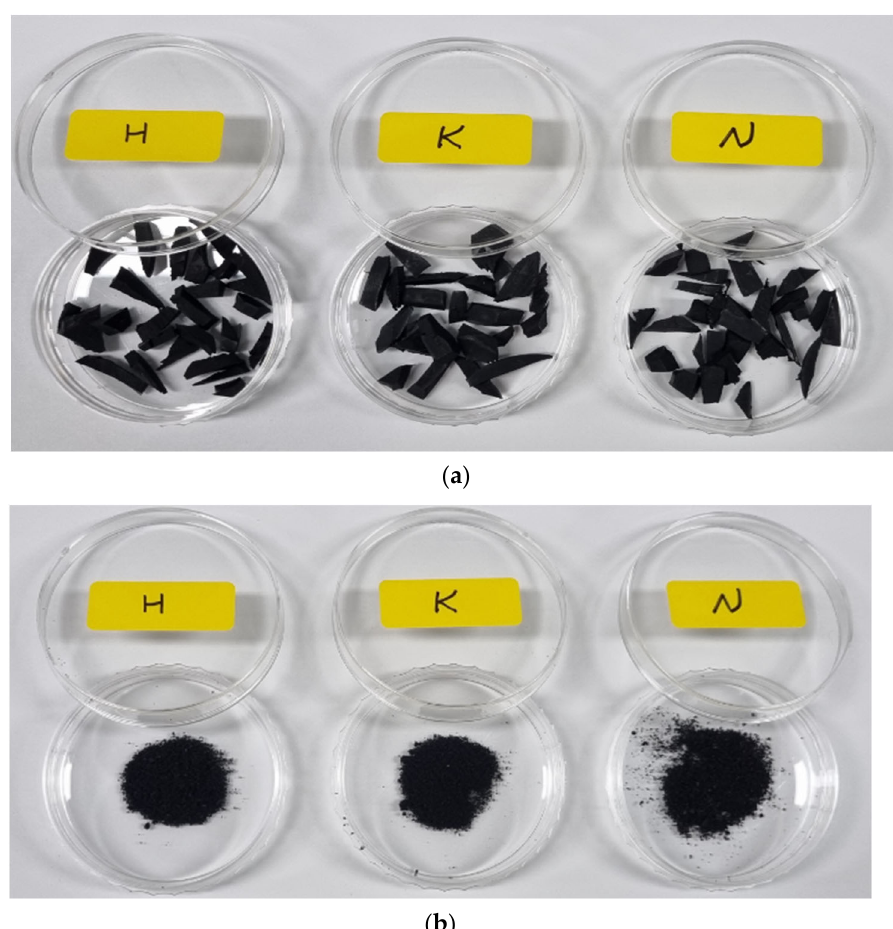
Figure 3. The bulk sample cut from the tread of tires in the vehicles passing by the road ( a ) and very tiny particle samples ( b